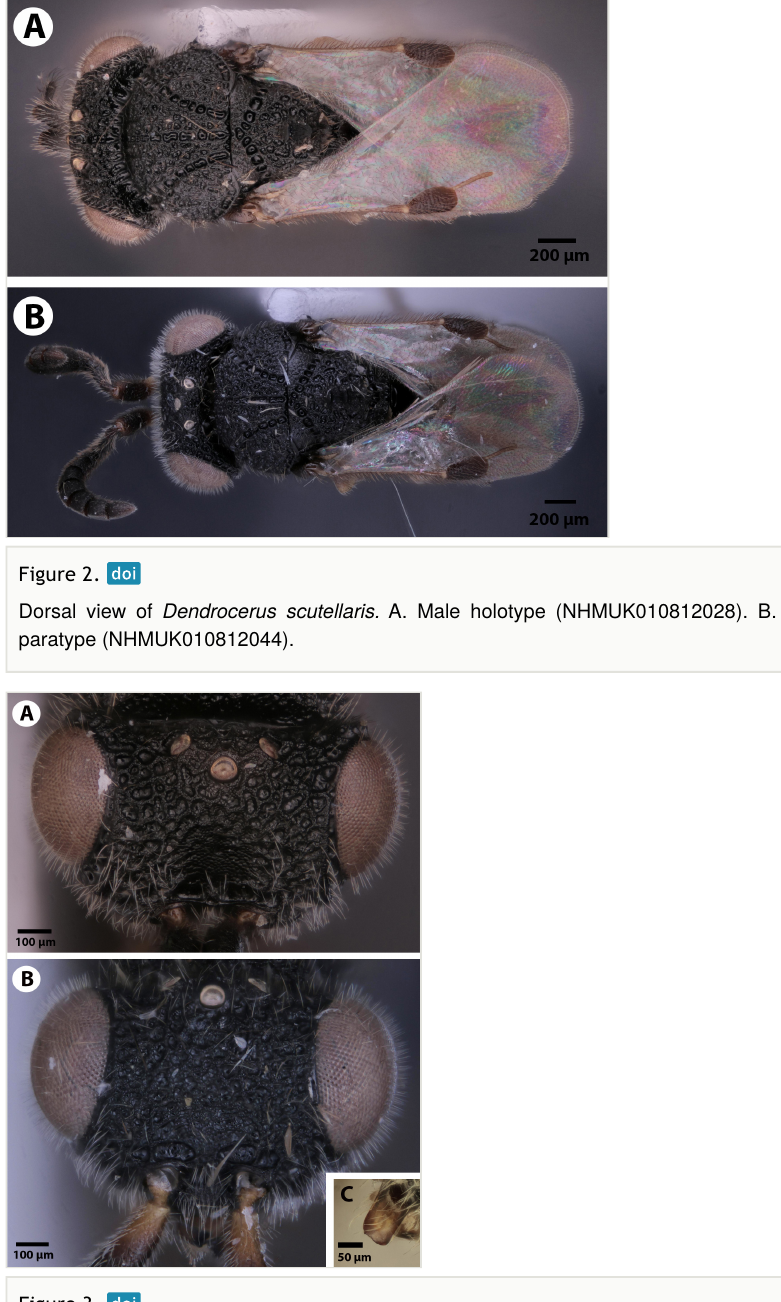
Figure 3. Frons of Dendrocerus scutellaris. A. Male holotype (NHMUK010812028). B. Female paratype (NHMUK010812044). C. Image showing the fl at distal edge of the mandible from the male paratype